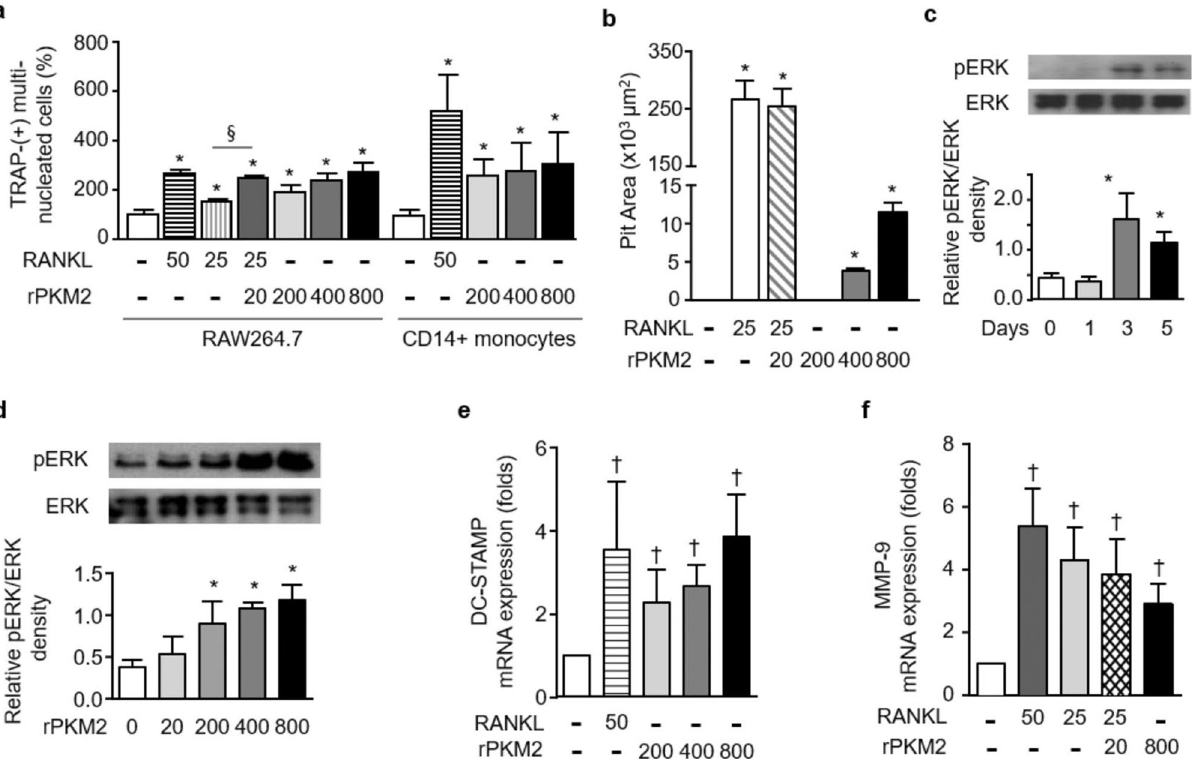
Figure 4. Extracellular PKM2 (exPKM2)-induced osteoclastogenesis through ERK signaling pathway. ( a ) TRAP-positive multinucleated cells were increased when RAW264.7 or human CD14 + cells were treated with RANKL or recombinant PKM2 (*p = 0.029 by the Mann–Whitney U test versus the unstimulated condition; n = 4). Suboptimal RANKL (25 ng/mL) induced formation of TRAP-positive multinucleated cells was significantly augmented when added a low dose (20 ng/mL) of recombinant PKM2 (rPKM2; §, p = 0.029). ( b ) In osteoclast activity assay, resorption pit area was significantly increased by rPKM2 or RANKL (*p = 0.029 versus the unstimulated condition; n = 4). ( c , d ) The level of phospho-ERK was significantly increased in RAW264.7 cells treated with rPKM2 for 3 days and in a dose-dependent mode (*p = 0.029 versus the unstimulated condition; n = 4). Uncropped images are shown in Supplementary Fig. 3a,b. ( e , f ) When RAW264.7 cells were treated with RANKL or rPKM2, DC-STAMP and MMP-9 mRNA levels were significantly increased ( † p = 4.11 × 10 –5 ; n = 3). Data with error bars were expressed as mean ±